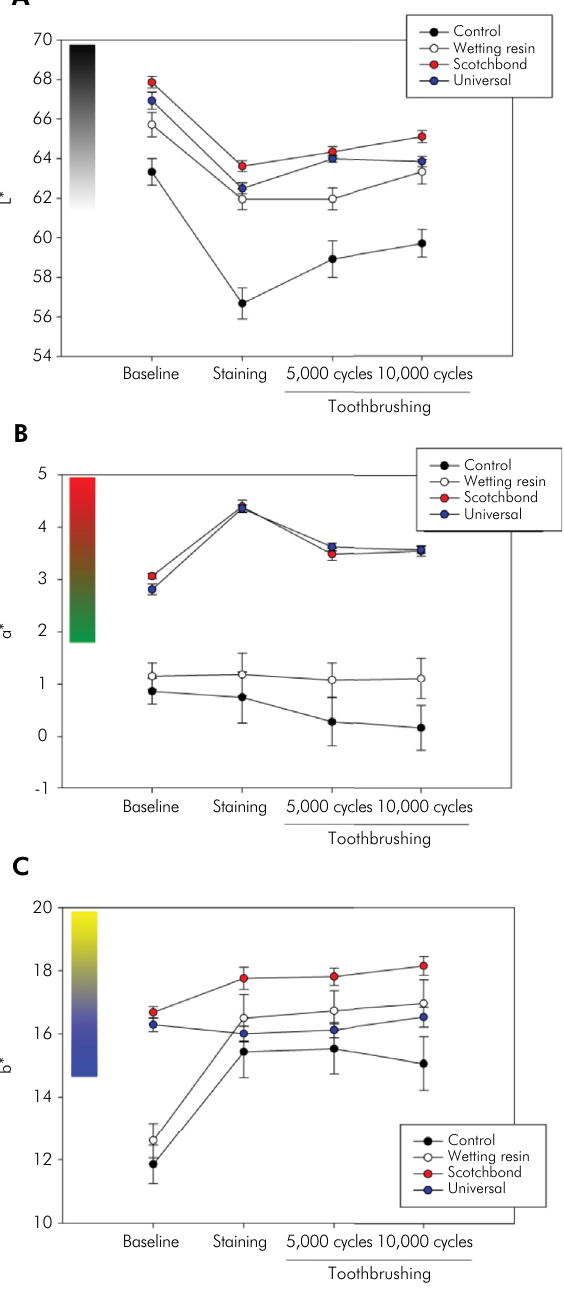
Figure 2. Illustrative disc-shaped resin composite specimens, based on data from L*a*b* converted to the RGB